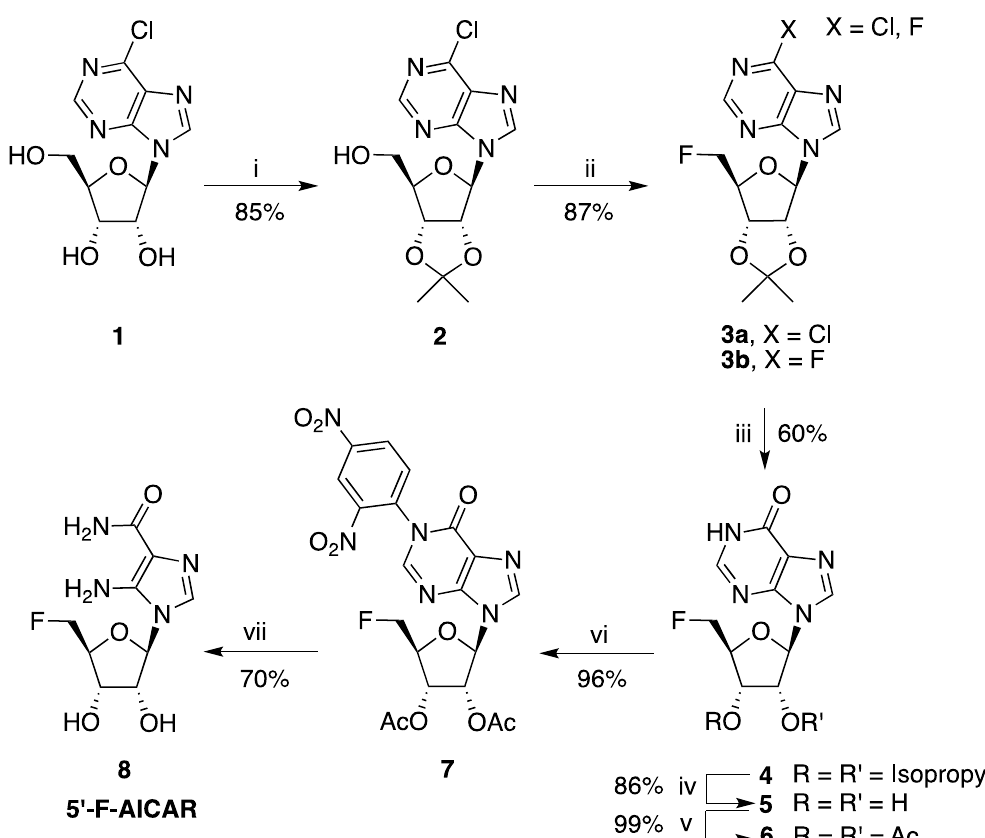
Scheme 1. Preparation of compound 5 ′ -F-AICAR 8